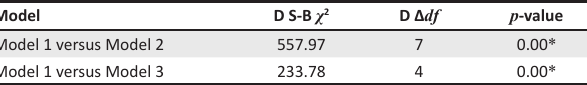
TABLE 3: Difference testing for changes in chi-square in competing measurement models. Model